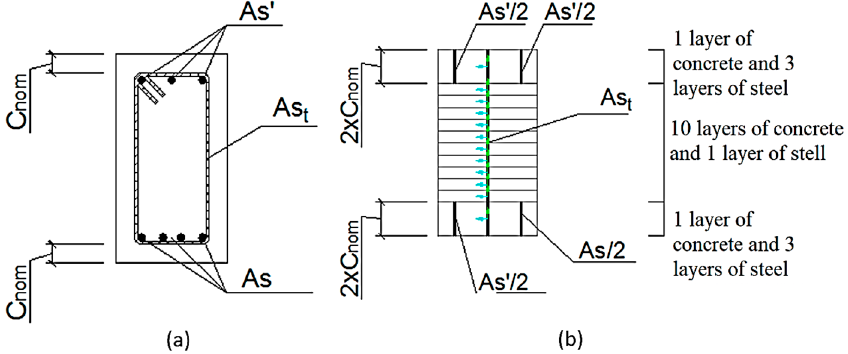
Figure 11. Cross-section for ( a ) Reinforced concrete slab and ( b ) non-linear Shell element.